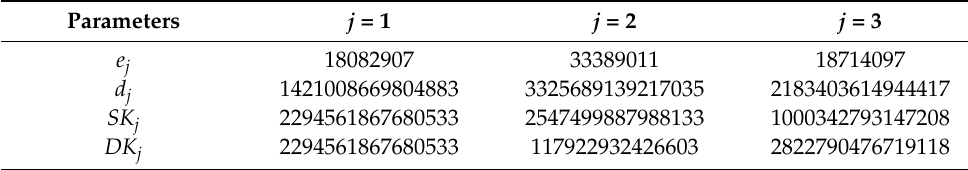
Figure 8. The result of Figure 7b.